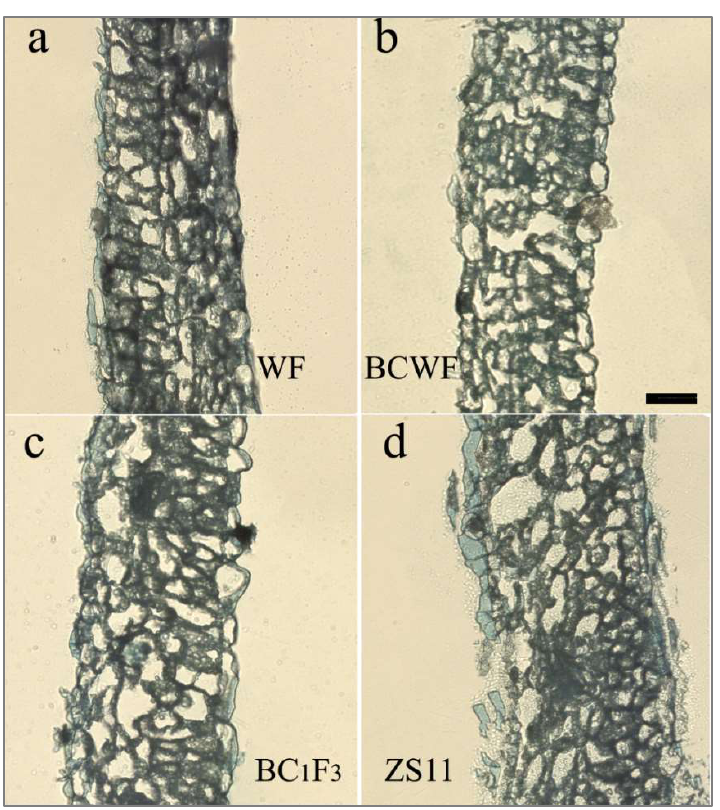
Figure A1. Transverse sections of the leaf samples of four plant accessions, ‘WF’ ( a ), ‘BCWF’ ( b ), ‘BC 1 F 3 ’ ( c ) and ‘ZS11’ ( d ). The images have the same magnification and scale bar = 100 µm.